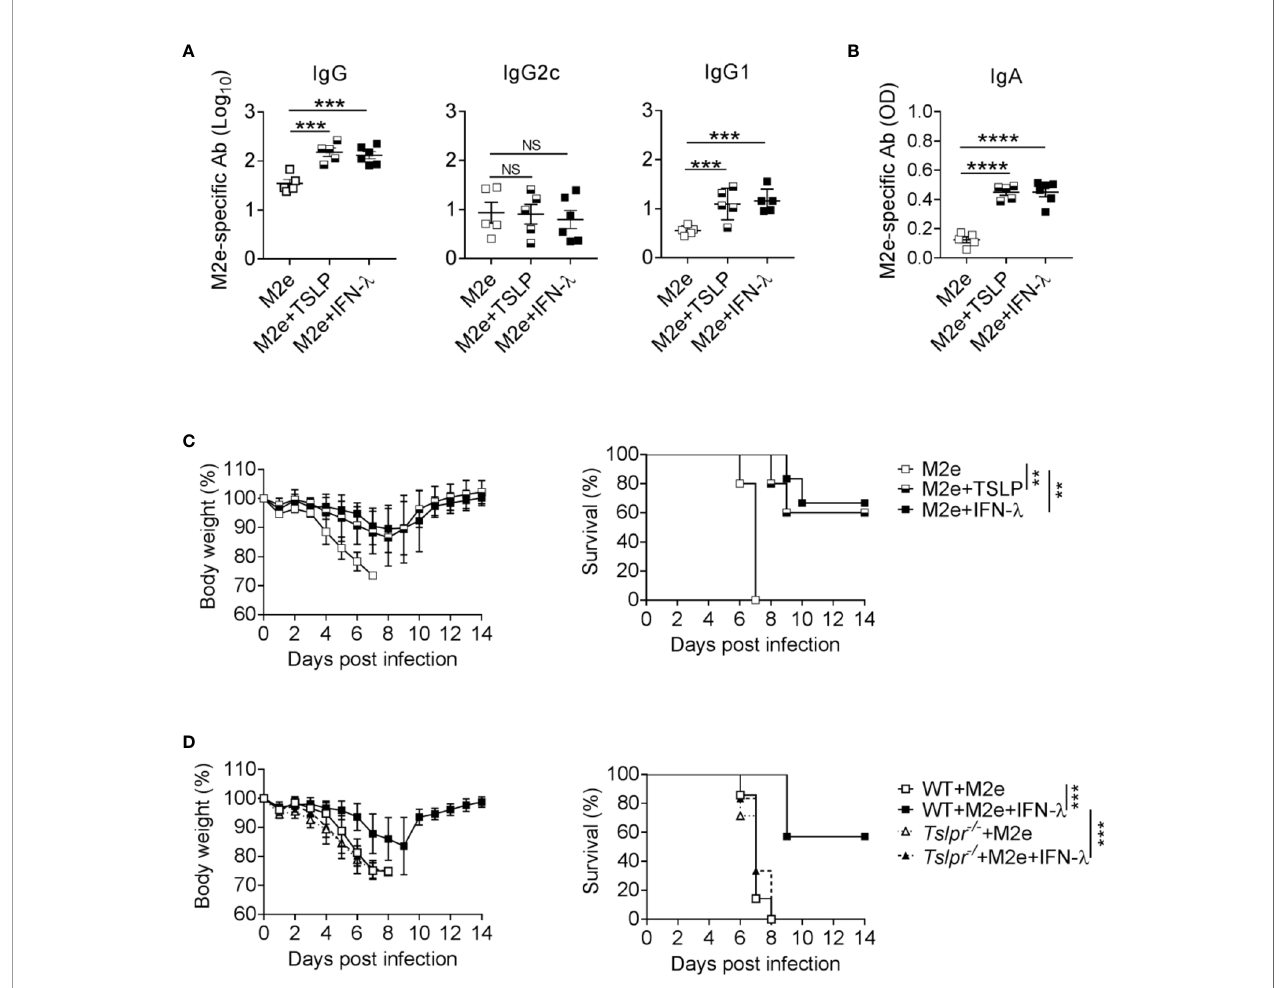
FIGURE 4 | The IFN- l /TSLP axis enhances the ef fi cacy of rectally administered M2e vaccine. (A – C) B6-WT mice were immunized by the rectal route with CTA1- 3M2e-DD (M2e) alone (n = 5), M2e+TSLP (n = 5) or M2e+IFN- l (n = 6). Ten days later, all mice received a booster immunization. M2e-speci fi c antibodies in (A) sera and (B) BAL fl uid on day 10 after booster immunization were measured by ELISA. Each symbol represents an individual animal. Results are representative of three independent experiments and shown as mean ± SEM. ***P < 0.001 and ****P < 0.0001 by one-way ANOVA with Tukey ’ s multiple-comparison test. NS, no signi fi cant difference. (C) Groups of immunized mice were challenged with 50 PFU of in fl uenza A virus strain PR8/34. Weight loss and survival were monitored daily for 14 days. Animals were sacri fi ced when they lost 25% of their original body weight. Data are shown as mean ± SD. **P < 0.01, by log-rank test. (D) B6-WT (n = 7) and Tslpr – / – (n = 7) mice were rectally immunized with the CTA1-3M2e-DD (M2e) vaccine in the presence or absence of 1 m g IFN- l . Ten days later, all mice received a booster immunization and, 24 days later, they were infected with 50 PFU of in fl uenza A virus strain PR8/34 as in (C) . ***P < 0.001, by log-rank test. Data are pooled from two independent experiments and shown as mean ±